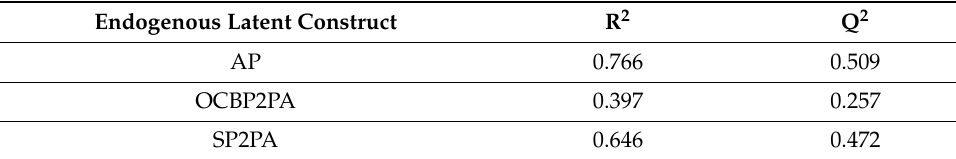
Table 4. Coefficient of determination R 2 and Q 2 of the model.